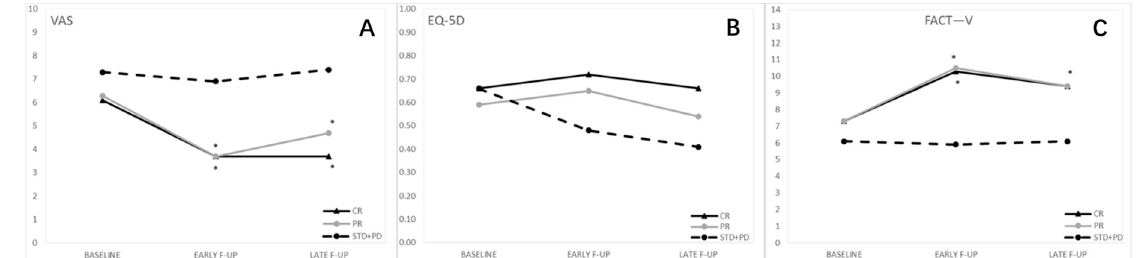
Table 1. Visual analog scale.